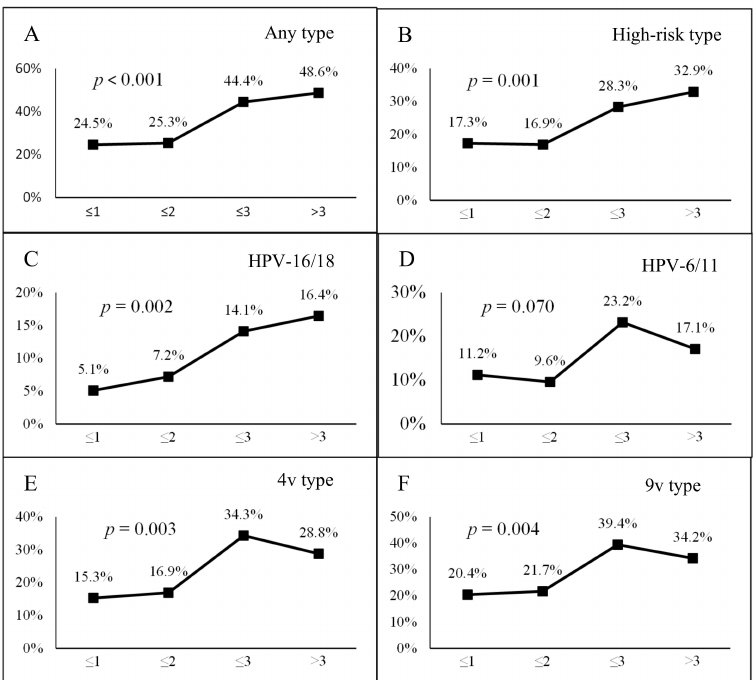
Figure 1. Proportions of any anal human papillomavirus (HPV) detection and the time since the first anal intercourse among men who have sex with men (MSM) attending university in